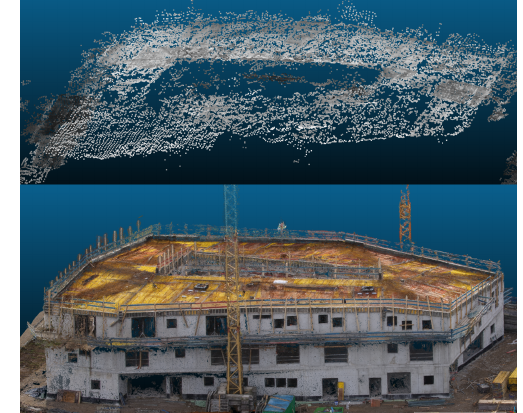
Figure 2. Dense point clouds from TIR images (top) and RGB images (bottom). The higher density of the RGB point cloud is clearly visible.